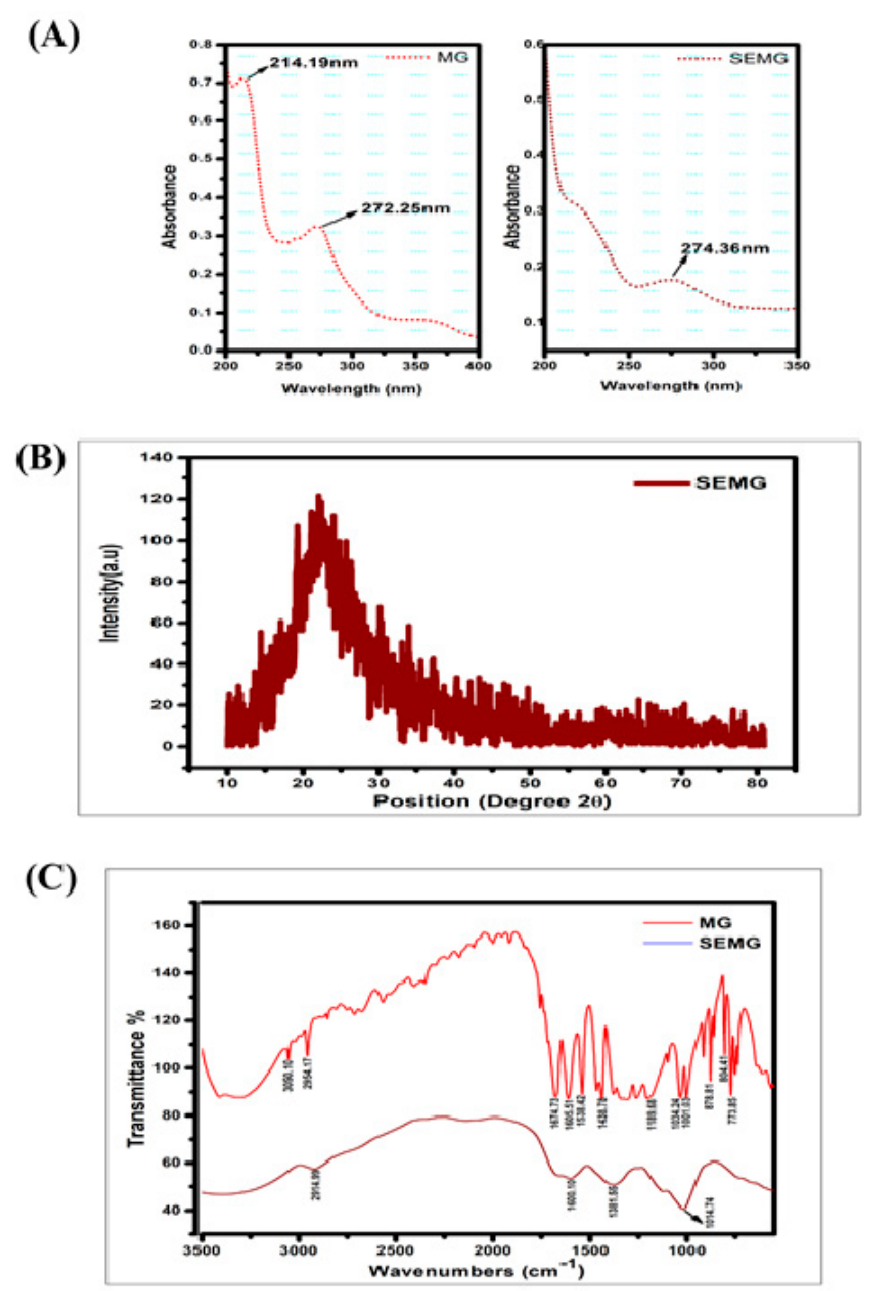
Figure 1. ( A ) UV-Visible spectrum of Methyl Gallate (MG) and Starch encapsulated methyl gallate (SEMG), ( B ) Powdered XRD spectrum of SEMG, ( C ) FTIR spectrum of SEMG (blue) and MG alone